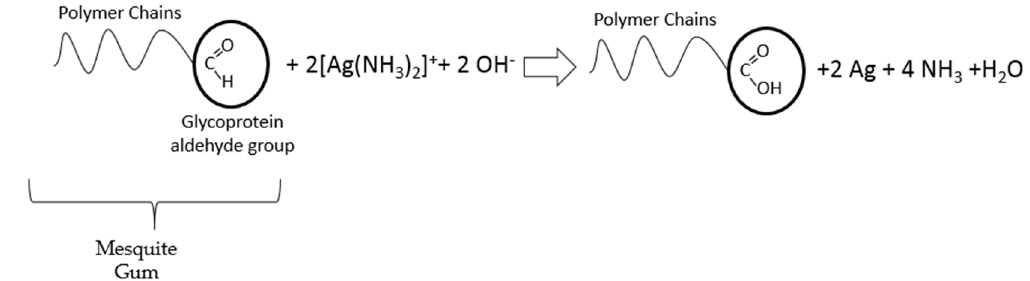
Figure 7. Schematic diagram of proposed reduction reaction.